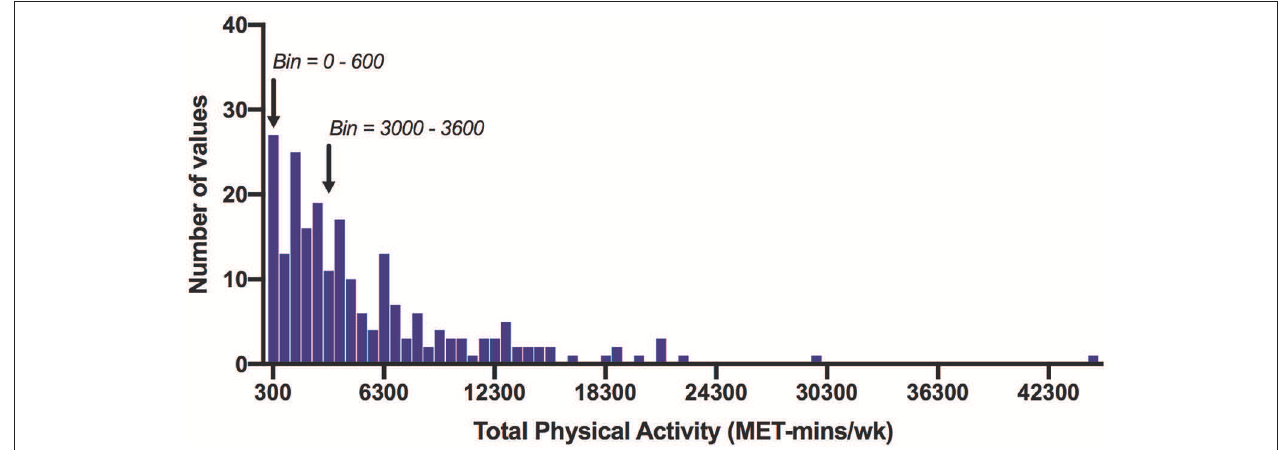
FIGURE 2 | Frequency distribution of total physical activity time measured with the IPAQ (MET-min/wk). Arrows indicate the 600 MET-min/wk and 3000 MET-min/wk thresholds. Of all participants, 12% did not achieve 600 MET-min/wk, and 45% did not achieve 3000 MET-min/wk. Bin width =